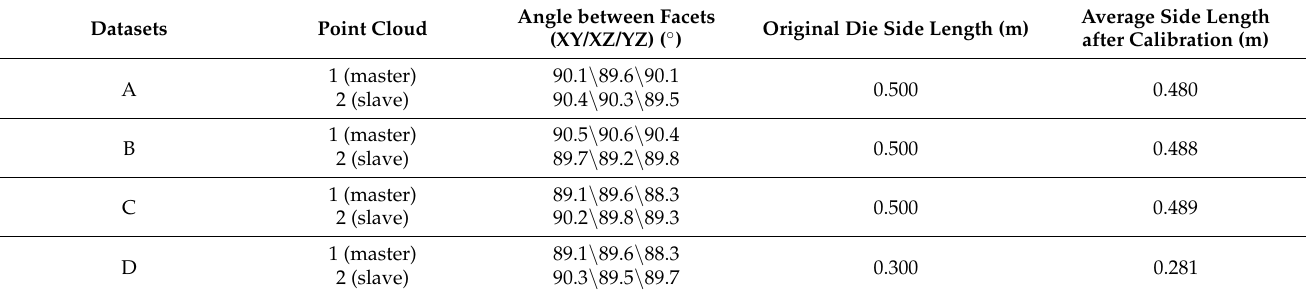
Table 6. Angles between each facet, and the average calibrated dimension of the dices.